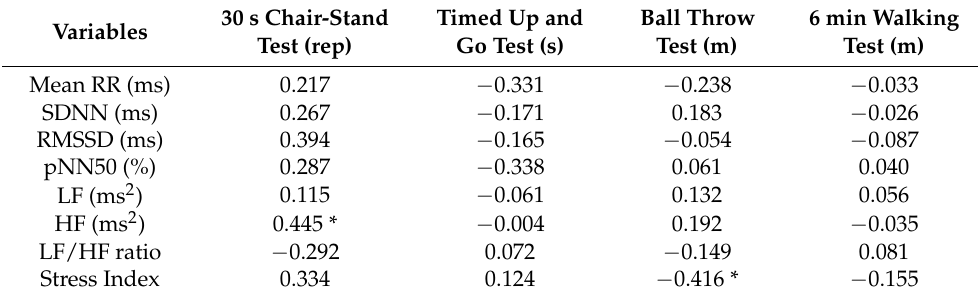
Table 4. Pearson correlations between heart rate variability and functional fitness.